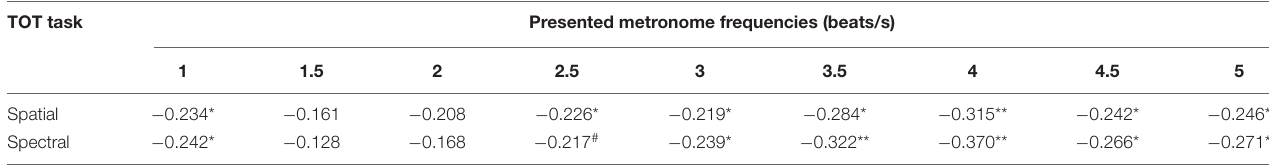
TABLE 3 | Spearman’s rho correlation coefficients (and significance levels) between TOT values obtained in the spatial and spectral temporal-order judgment task and MIILs for various metronome tempos. TOT task Presented metronome frequencies